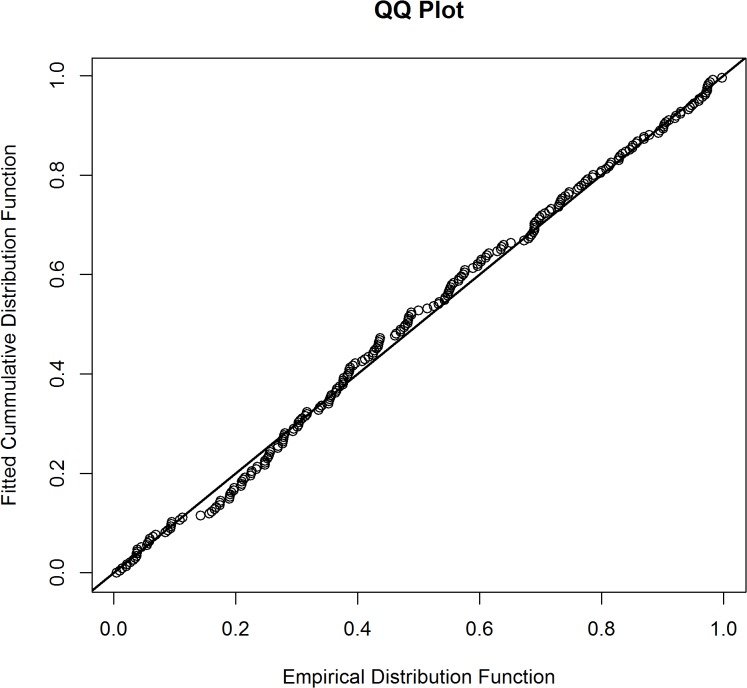
Q-q plot of the multiple covariate distance model fit.